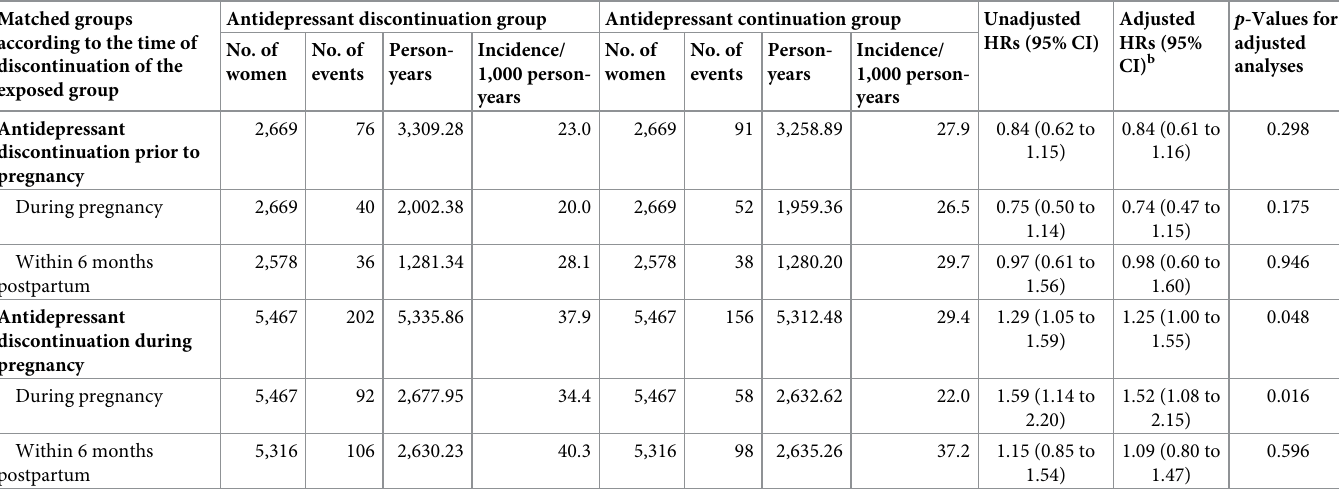
Table 2. Risk of psychiatric emergency associated with antidepressant discontinuation in propensity score–matched cohort analyses a . Matched groups according to the time